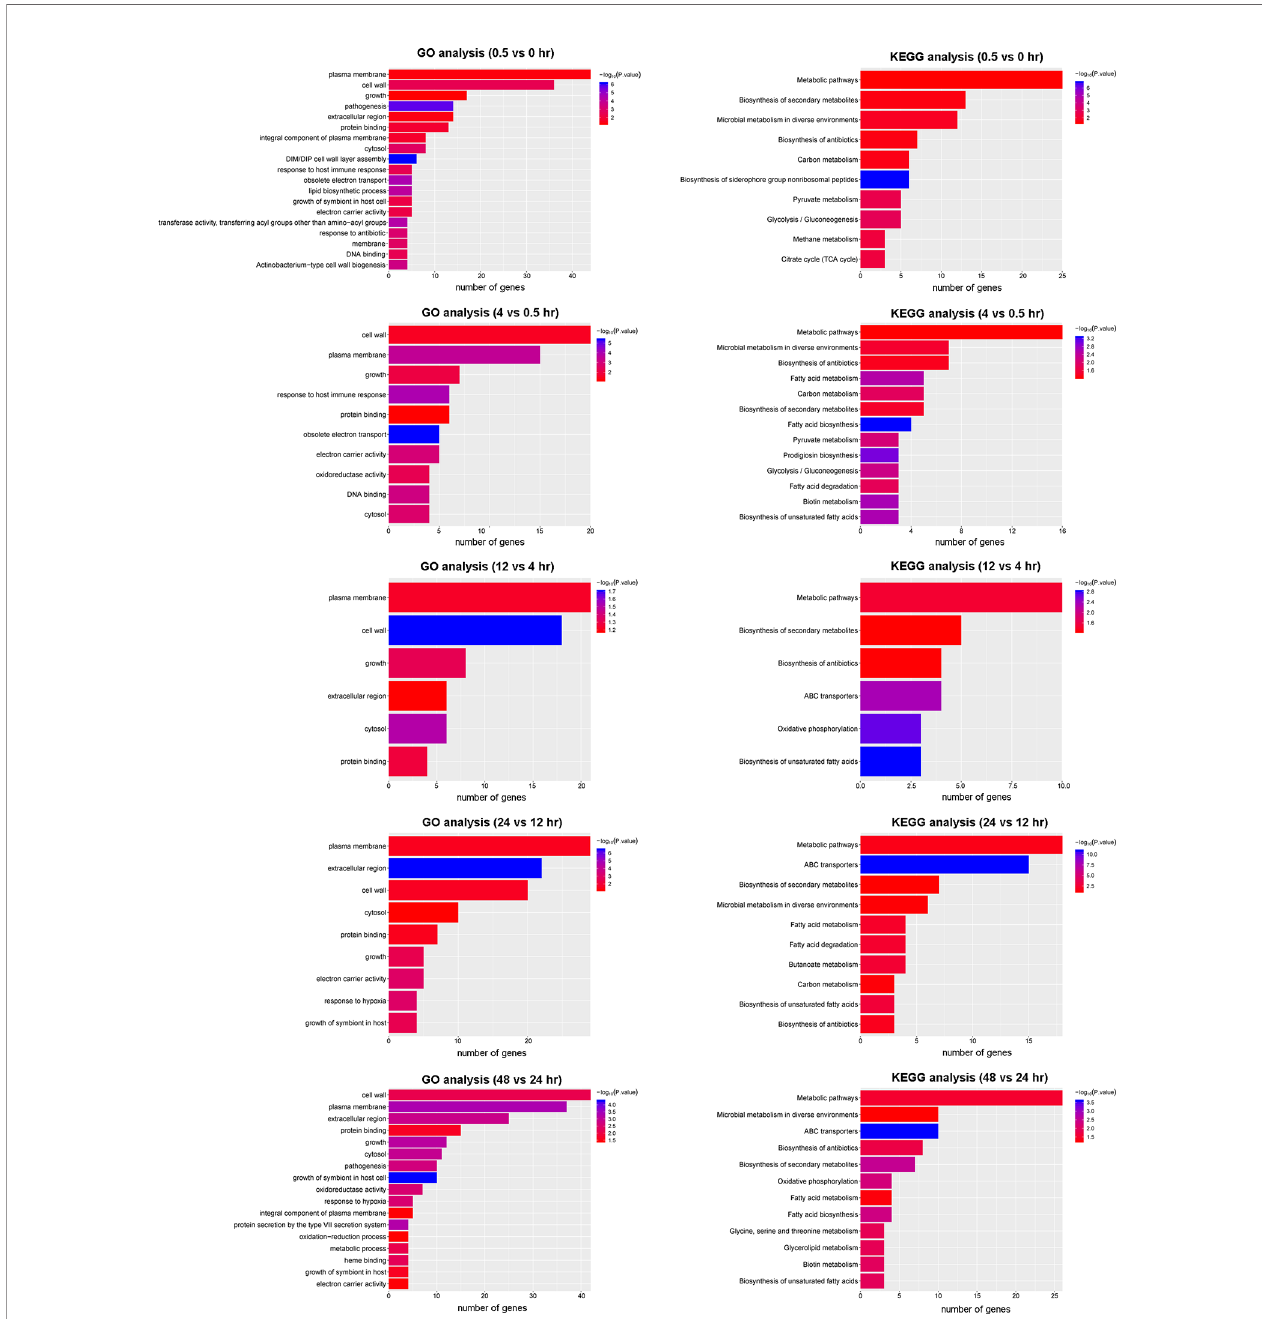
FIGURE 5 | GO and KEGG analysis of DEGs in the fi ve